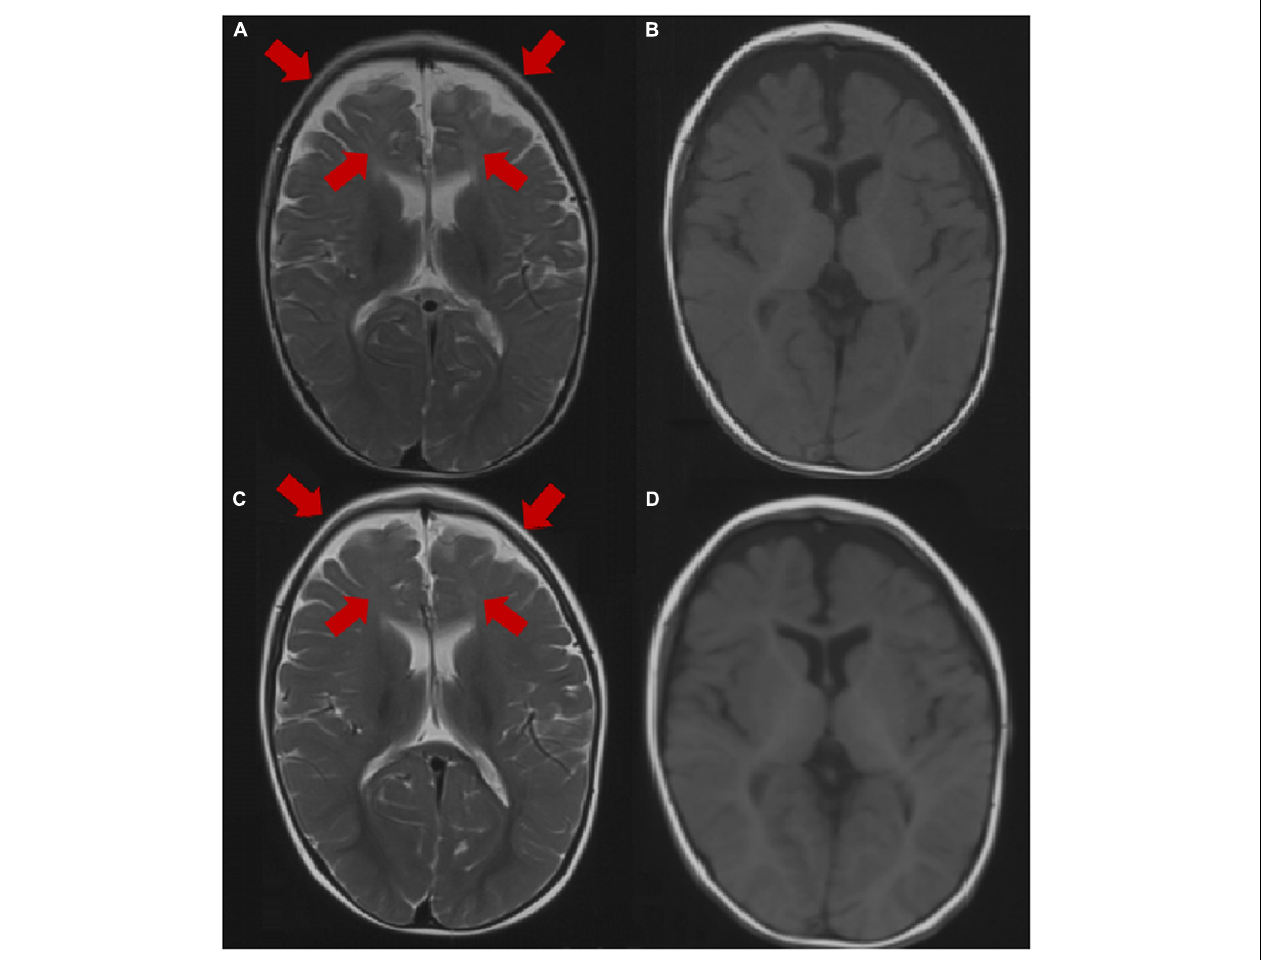
FIGURE 2 | Brain MRI image of patient 3 at the age of 1 year. (A,B) Axial images (T1WI and T2WI) showing dysplasia of the frontal and temporal cortex and delayed myelination. Brain MRI image of patient 3 at the age of 2 years. (C,D) Axial images (T1WI, T2WI) showing dysplasia of the frontal cortex and delayed myelination. The arrow points to the